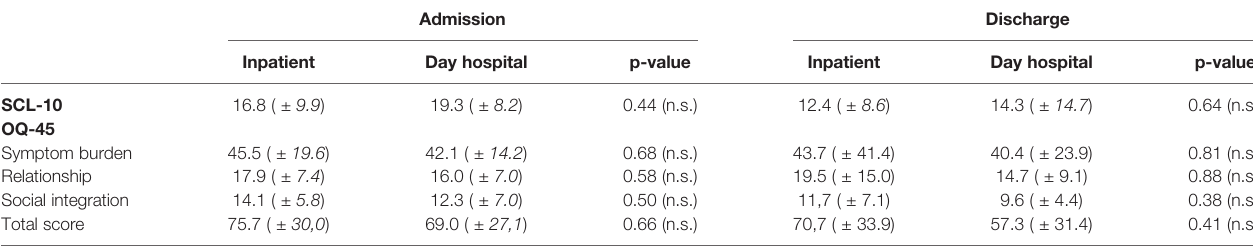
TABLE 5 | Symptom Check List (SCL-10) and Outcome Questionnaire (OQ-45), mean sum scores (± standard deviation ), p-values ( t -tests, inpatient versus day hospital).